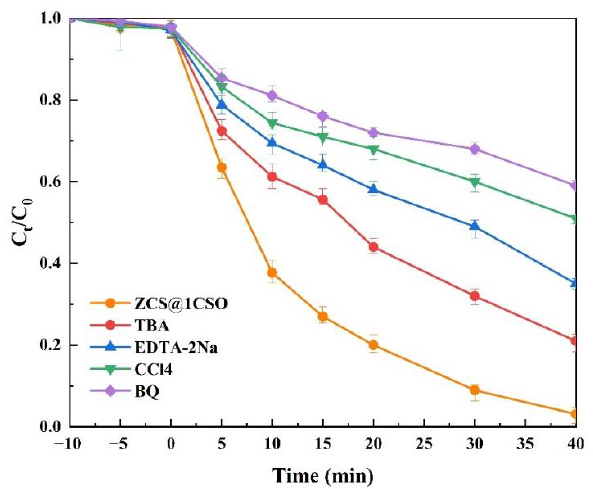
Figure 14. The influence of various trapping agents on the degradation process of